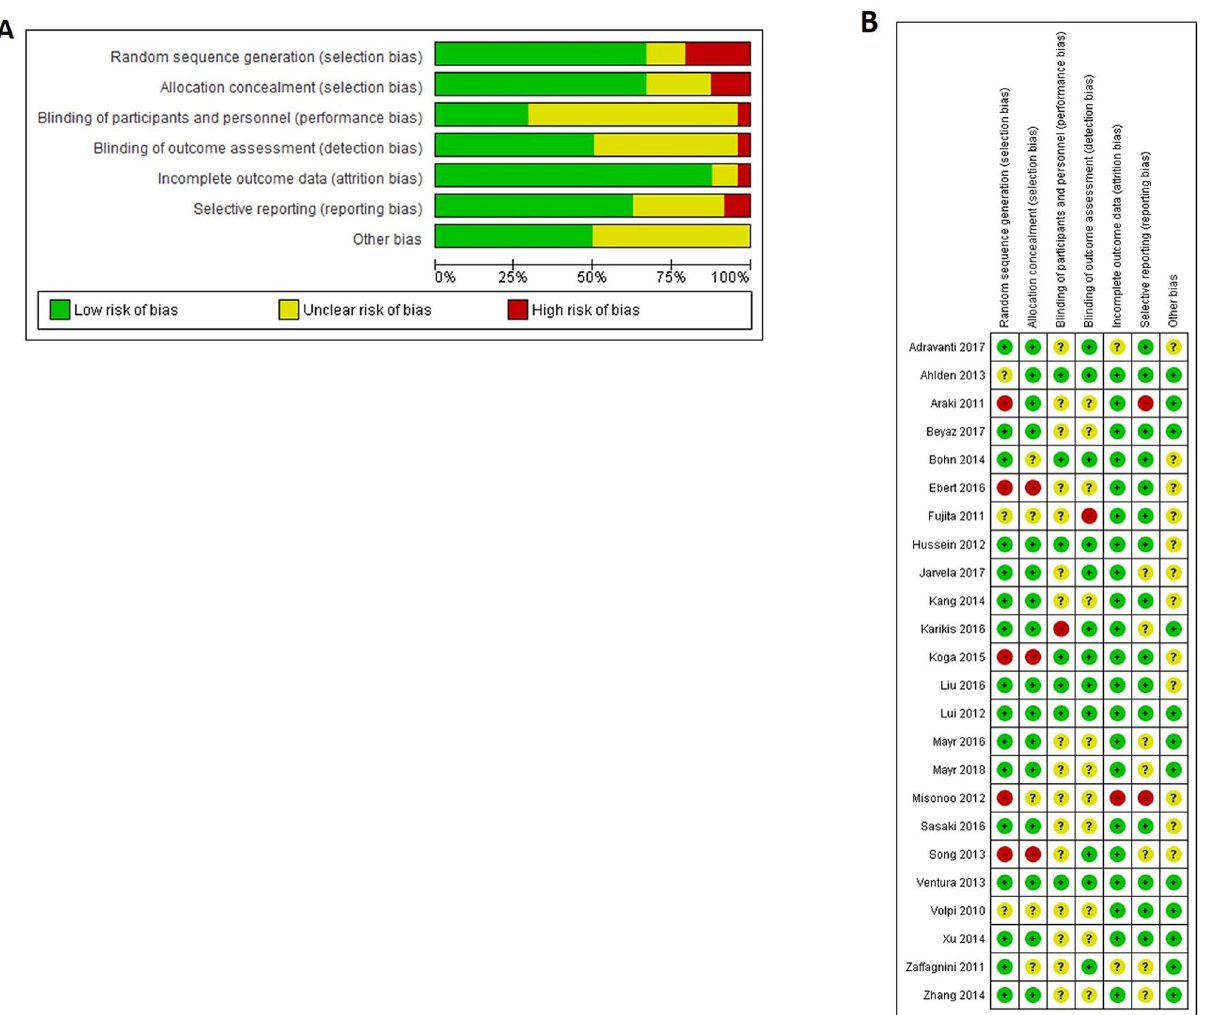
Figure 2. ( A ) Risk of bias within the included studies (24 studies, 1707 patients). ( B ) Risk of bias across included studies. The risk of bias was unclear for most of the studies. Data collected from RevMan 5.3